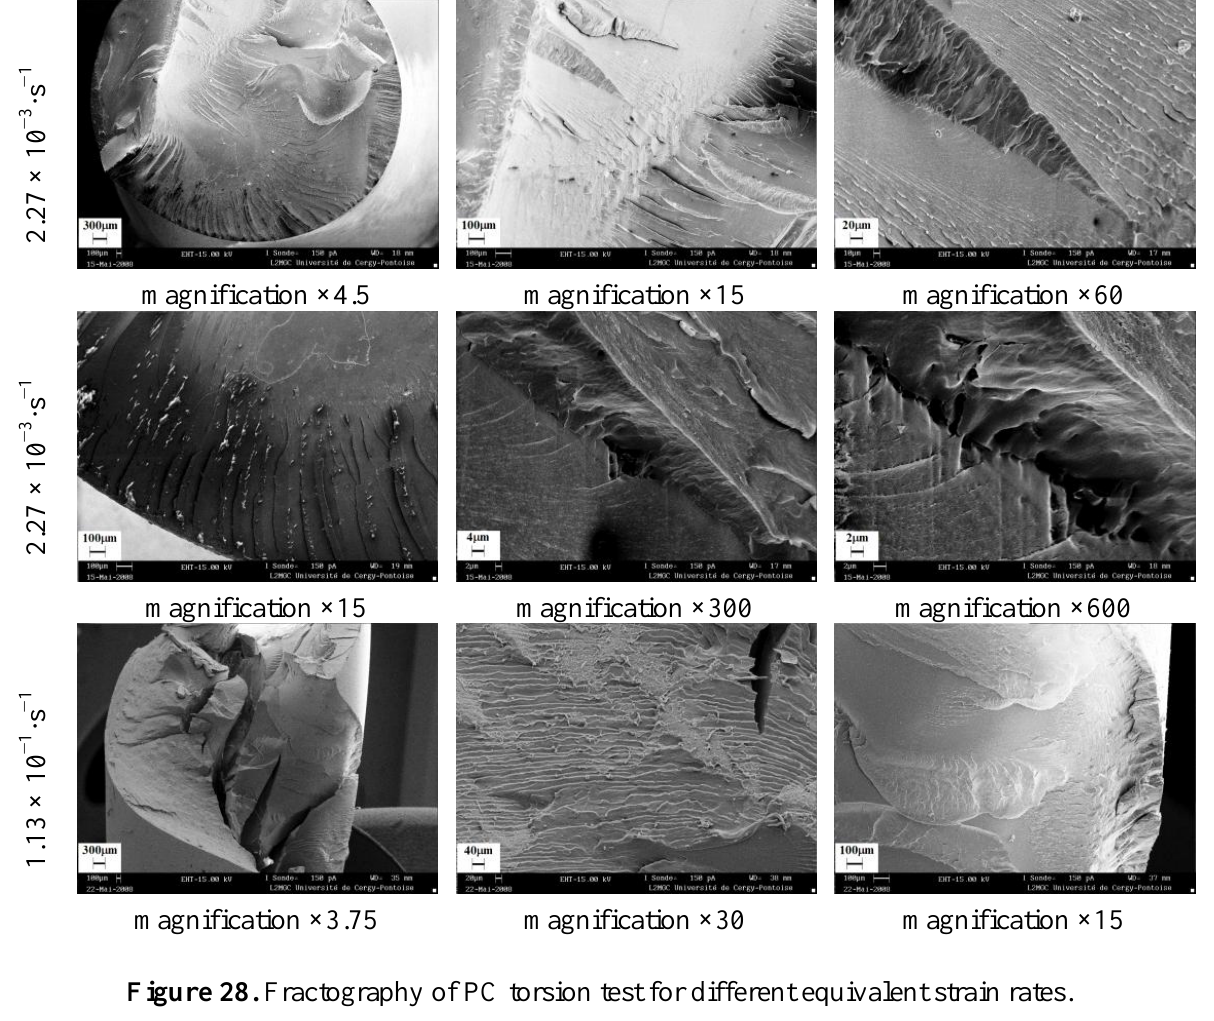
Figure 27. Fractography of PMMA torsion test for different equivalent strain rates.